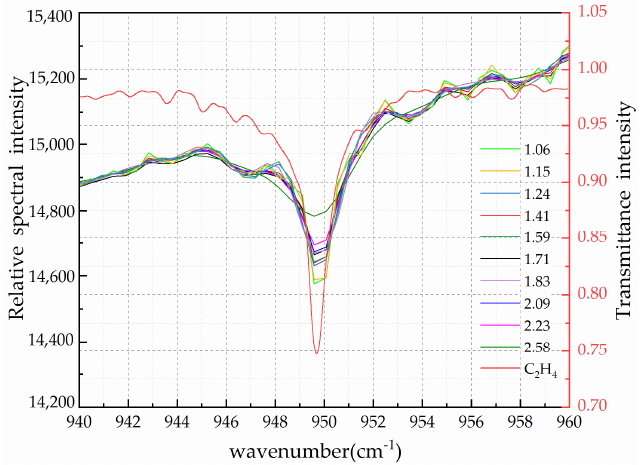
Figure 7. The C 2 H 4 spectrum with different apodization degrees and the C 2 H 4 standard transmis- sivity spectrum.